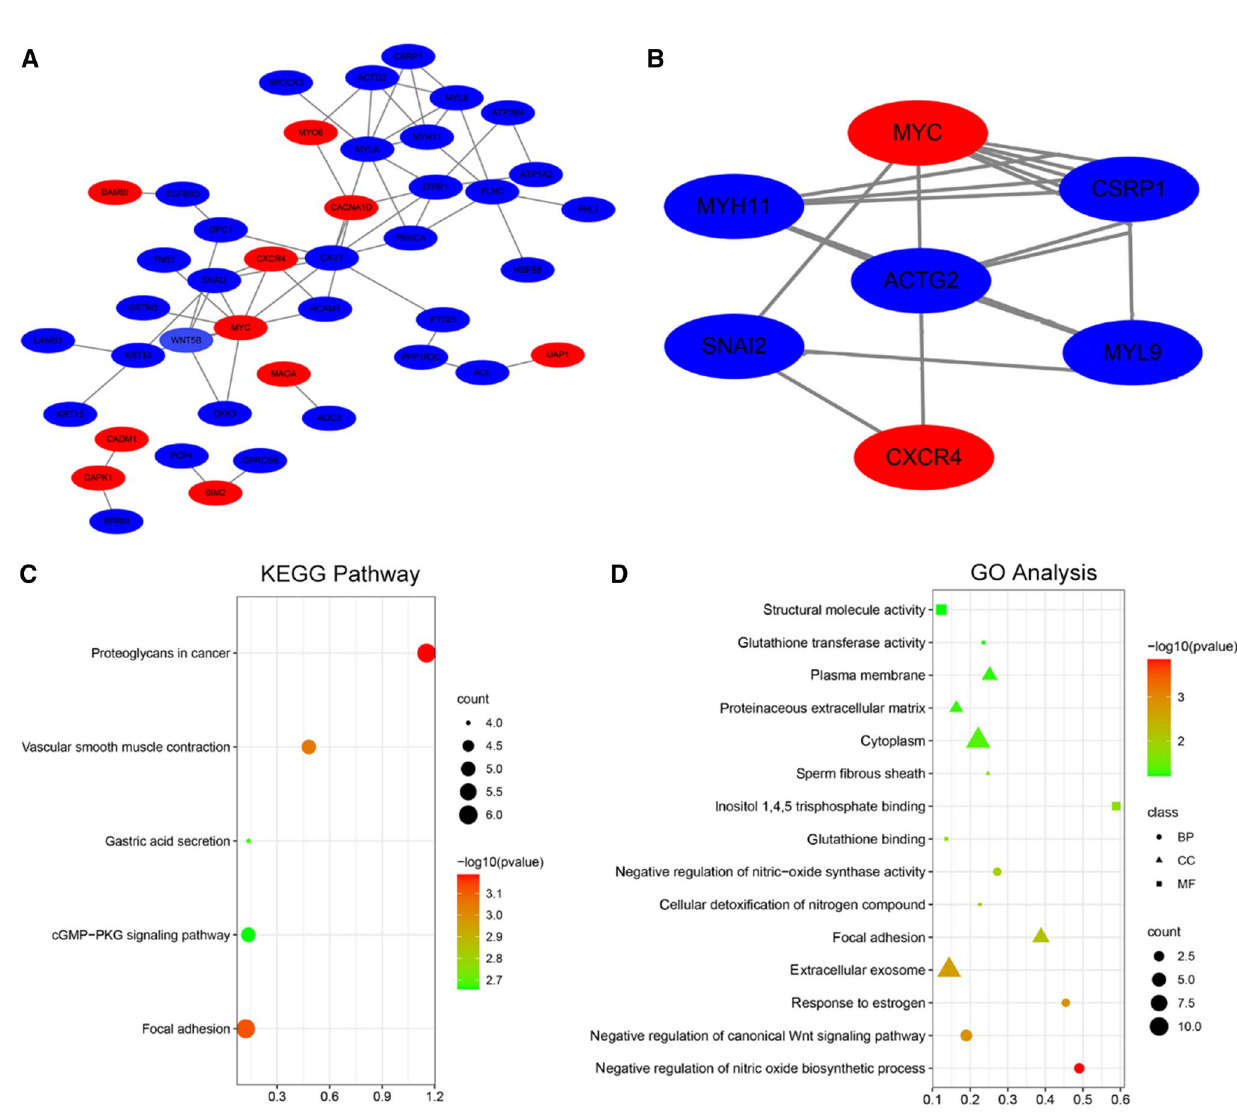
Fig. 2 PPI network, GO, and KEGG pathways were shown. A The PPI network of all DEGs. B The interaction of 7 hub genes in PPI network. C KEGG pathways of DEGs were shown in scatter map. D GO analysis of DEGs was exhibited in scatter map. Up-regulated gene reflects in Red and down-regulated gene reflects in